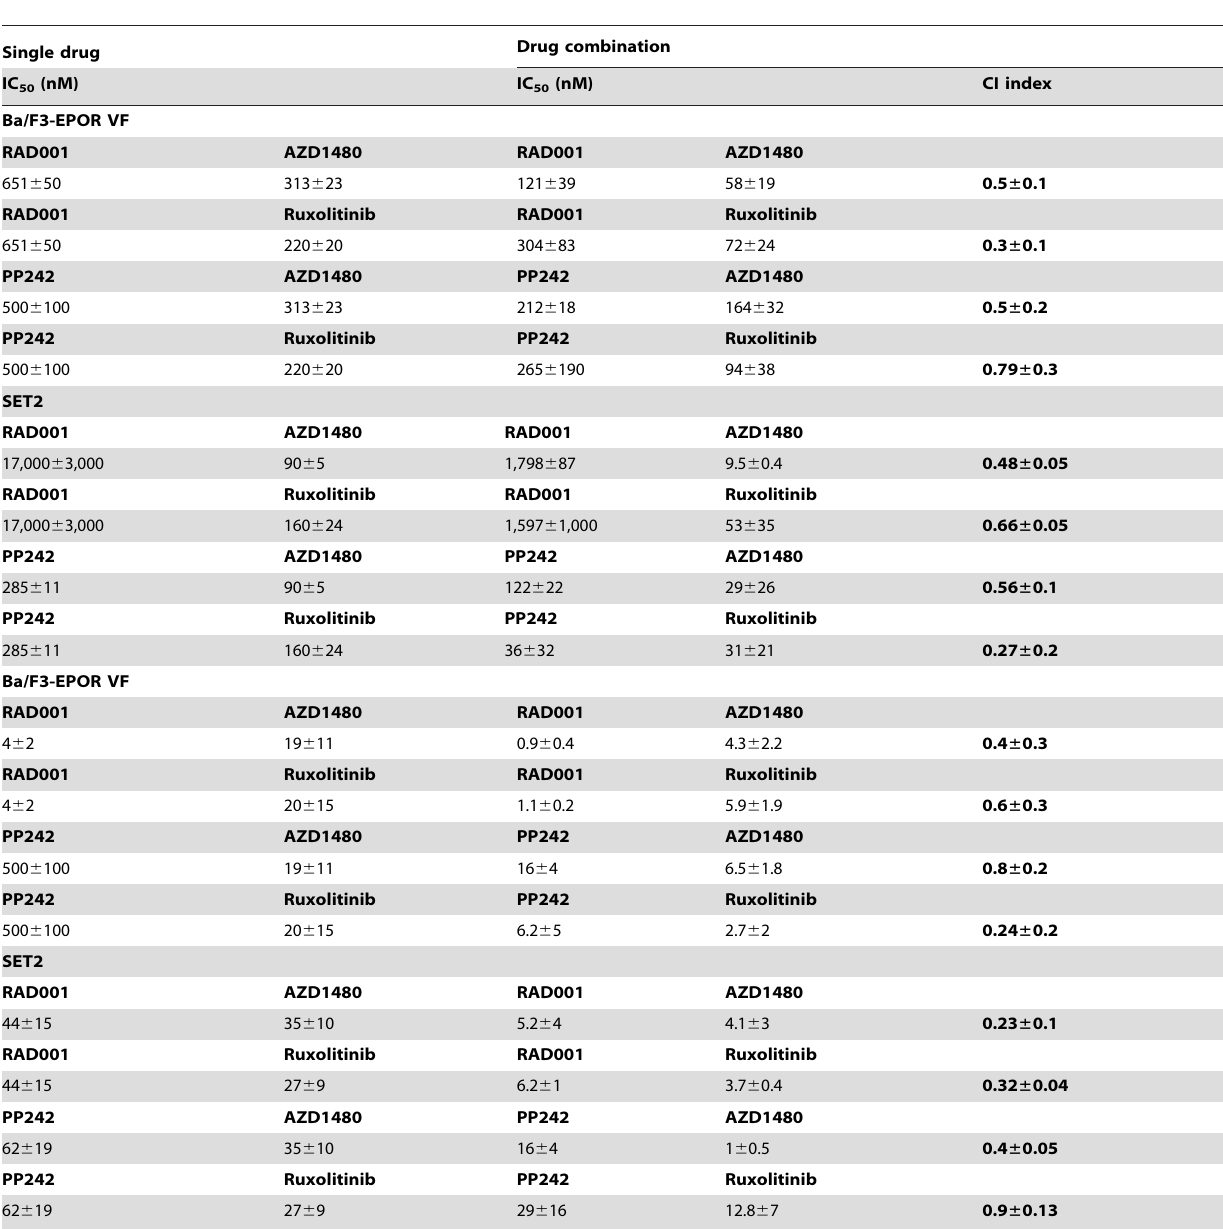
Data shown (mean 6 SD) are from at least two experiments. The Combination Index (CI) was calculated as described in Materials and Methods. A CI , 1 indicates that the interaction of the two drugs is synergistic. The first two columns report, for convenience, the IC 50 value of the individual drugs in these experimental settings (see Results section for details). with JAK2 inhibitors were similar, with IC 50 values lower than dishes containing vehicle only. As shown in Figure 3, colony formation from MPN patients was dose-dependently reduced by control of 1.6–21.4-fold in case of AZD1480 and 3–6.2-fold in case mTOR inhibitors; the data reported in Table 2 indicate that MPN of Ruxolitinib. By keeping separate JAK2 V617F positive and progenitor growth could be inhibited with IC 50 drug concentra- negative PMF subjects (n= 5 each) we did not observe appreciable difference in the inhibitory effect of either drugs depending on the tion significantly lower than control cells (in case of RAD001, from JAK2 mutation status of the patients (not shown in detail). Finally, 4.7 to 13-fold lower and in case of PP242 from 2.6 to 6.1-fold we determined that the growth of EEC from circulating lower, depending on colony type), pointing to a substantial degree progenitors in PV patients (n= 5) could be inhibited at very low of drug selectivity against MPN cells. Progenitors forming nanomolar concentrations of RAD001 (IC 50 = 15.0 6 10.0 nM), megakaryocytic colonies were the most sensitive. Results obtained